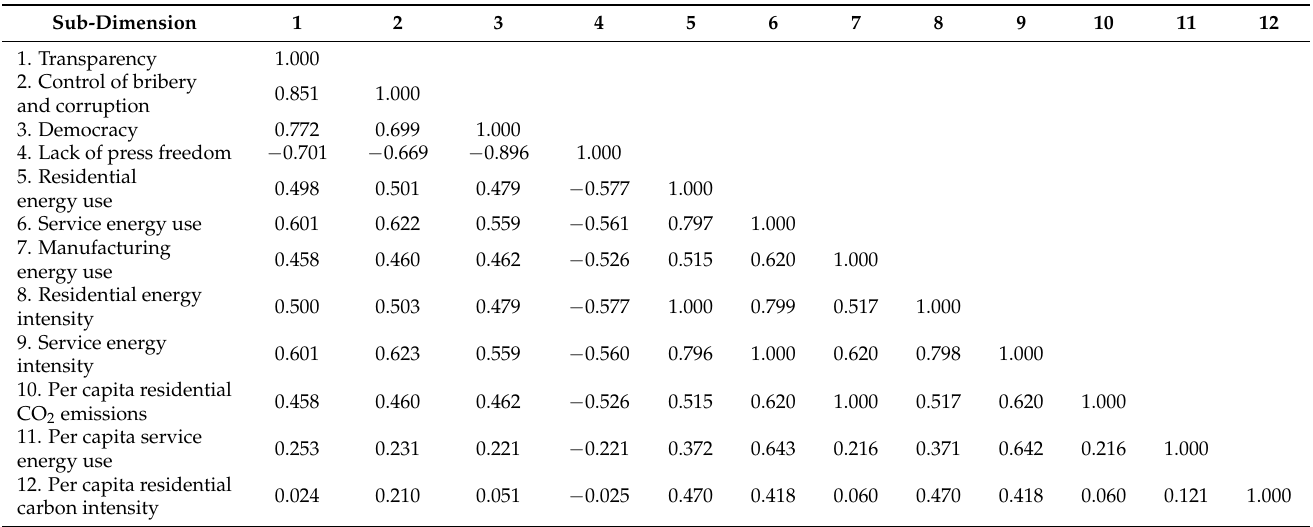
Table 3. Sub-dimensional correlation